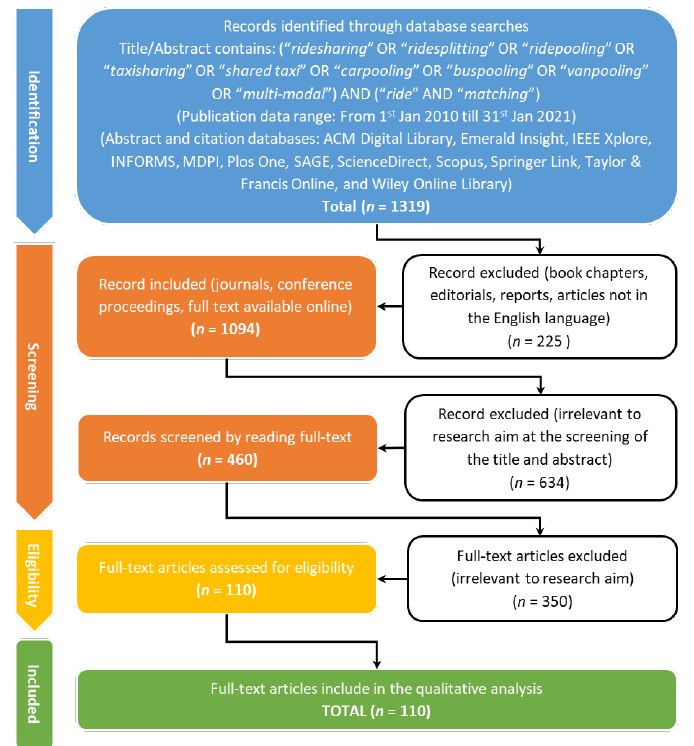
Figure 1. Literature selection procedure (PRISMA four-phase flow